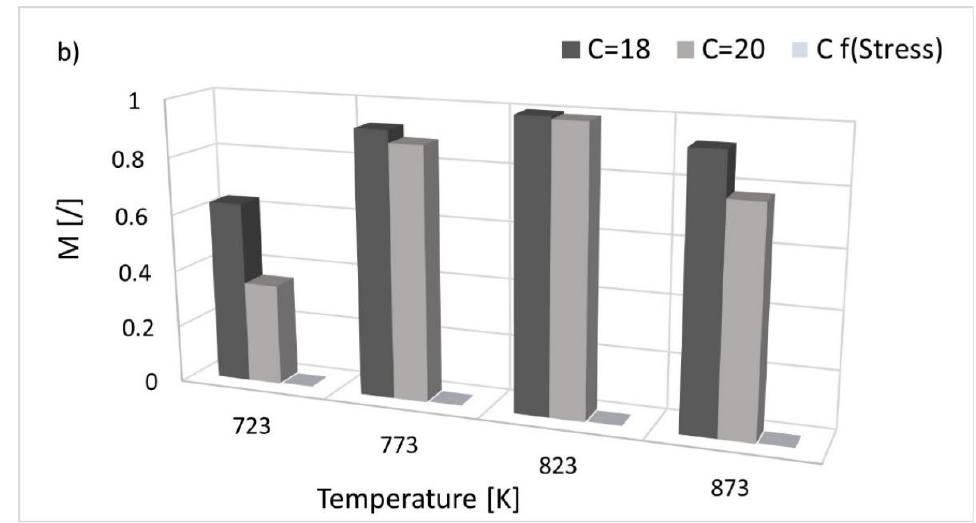
Figure 7. Comparison of fit adequacy parameter 𝑀 for calculations performed using ( a ) the linear fit function and ( b ) the polynomial fit function, using different values of parameter 𝐶.